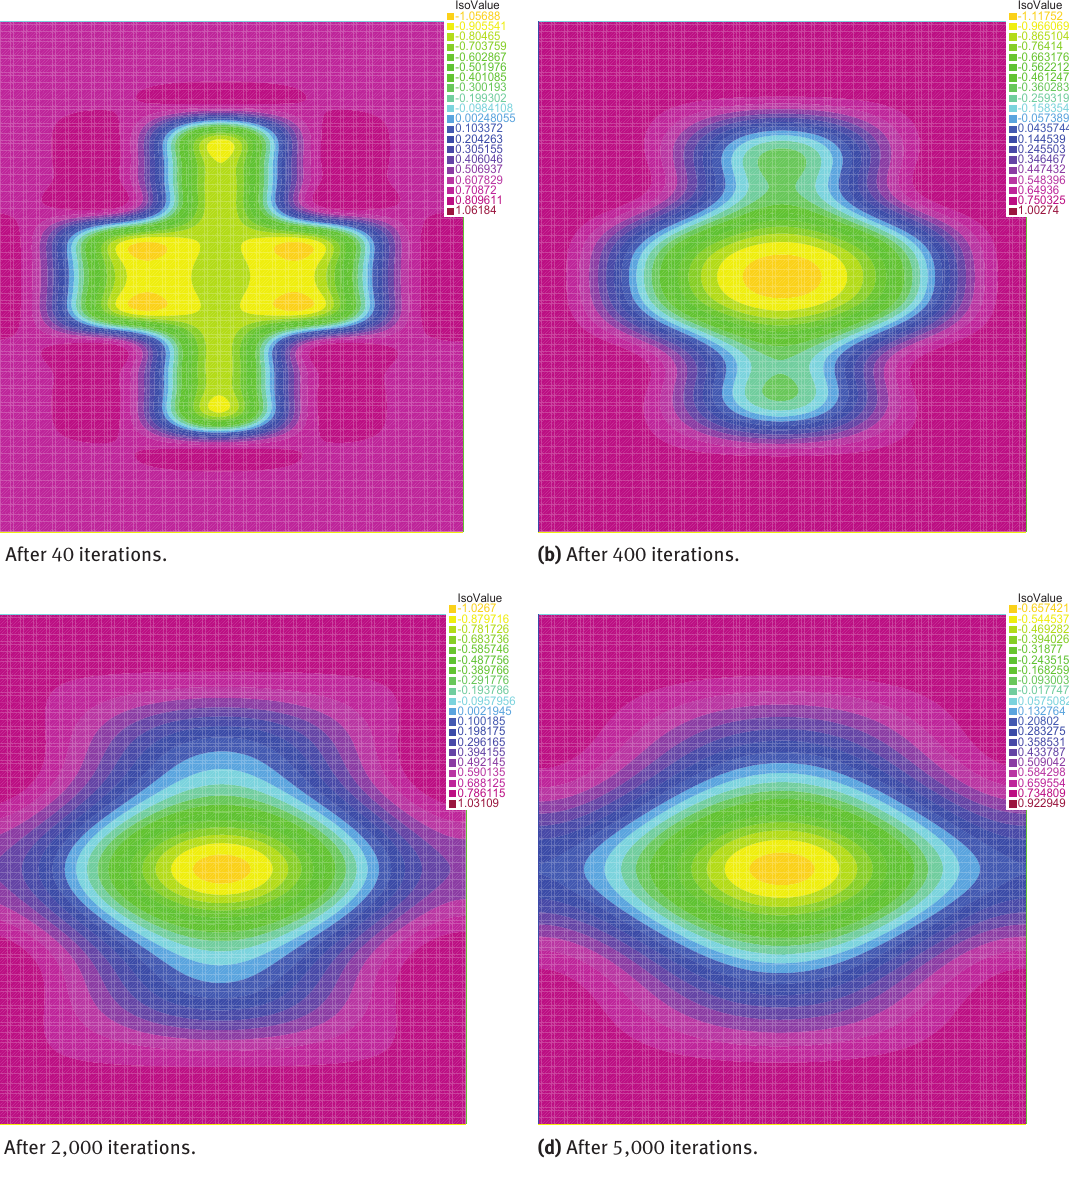
Figure 9: Results for k = 2, dt = 10 − 7